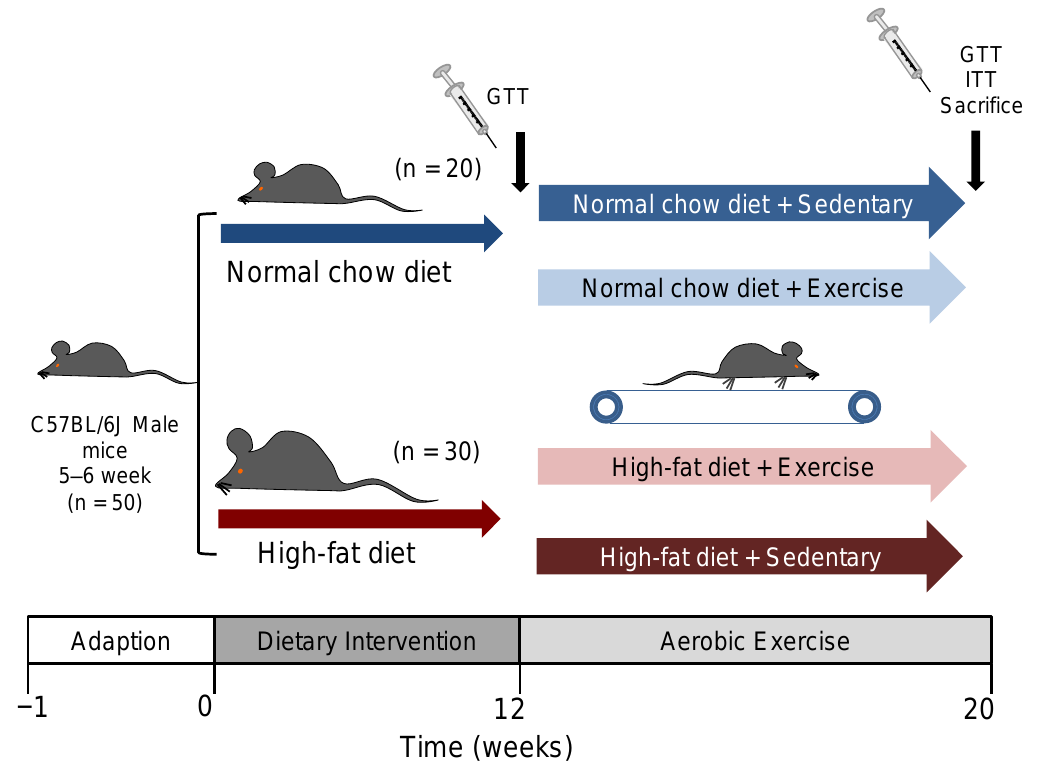
Figure 1. Experimental design of the study. GTT, glucose tolerance test; ITT, insulin tolerance